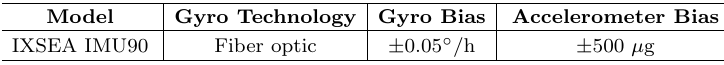
Table 2: IMU specifications